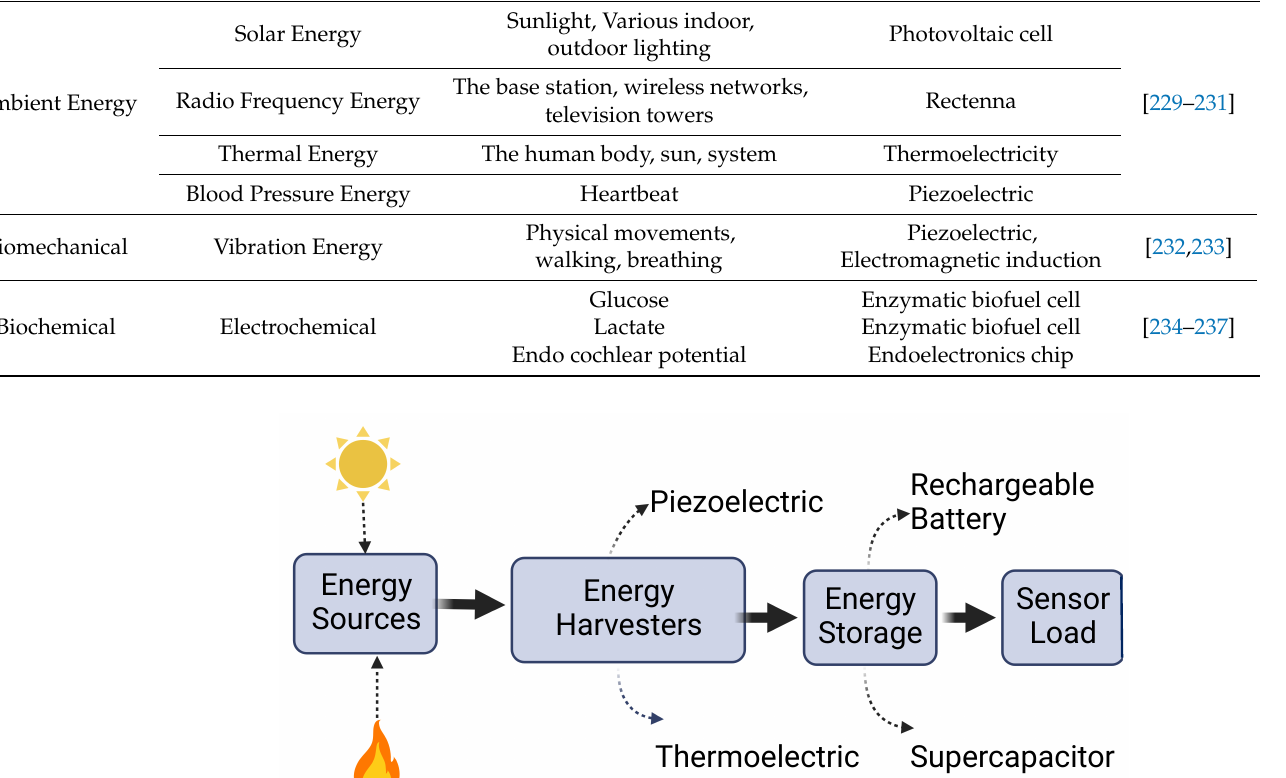
Table 9. The energy sources can be classified into different categories